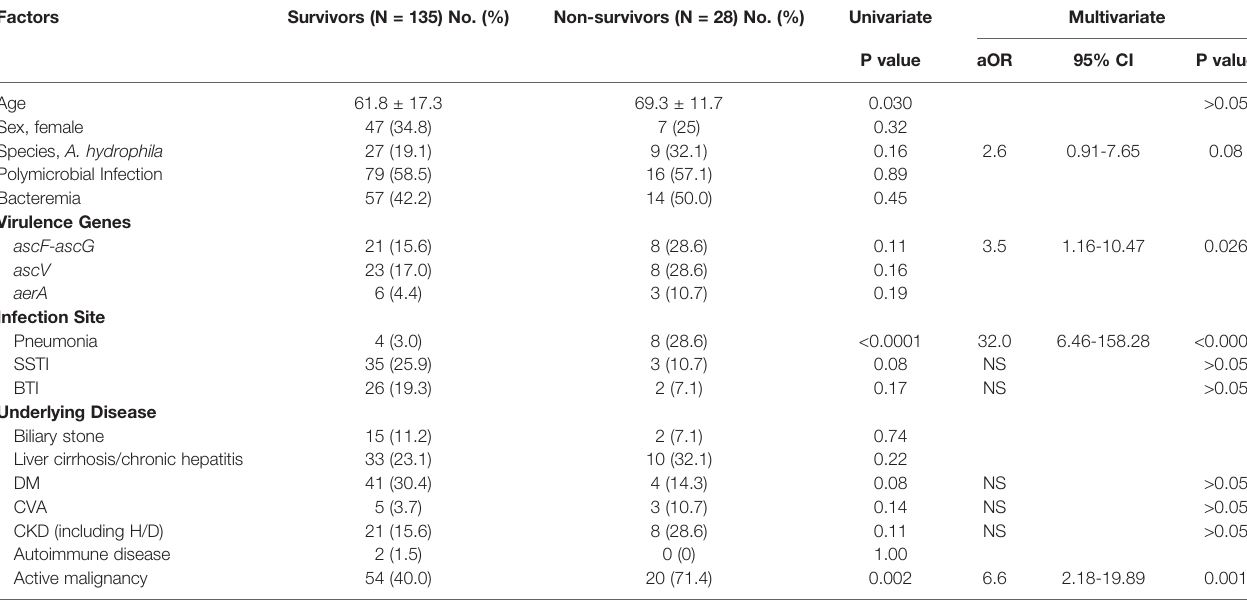
TABLE 5 | Univariate and multivariate analysis pf risk factors for patients with Aeromonas infection. Factors Survivors (N = 135) No.